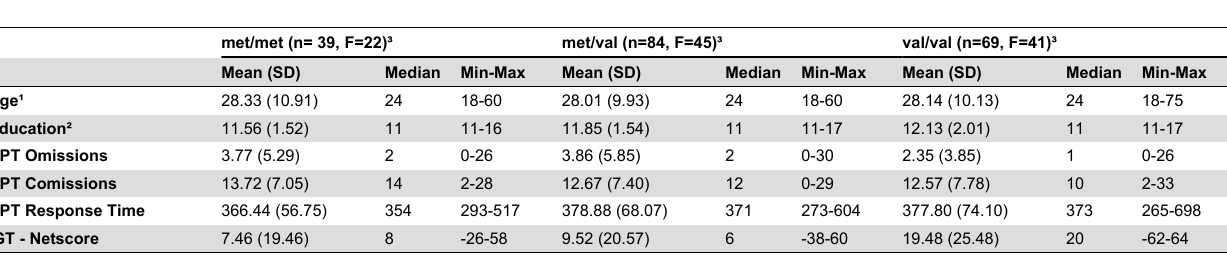
Table 1. Participants description and performance on neuropsychological impulsivity